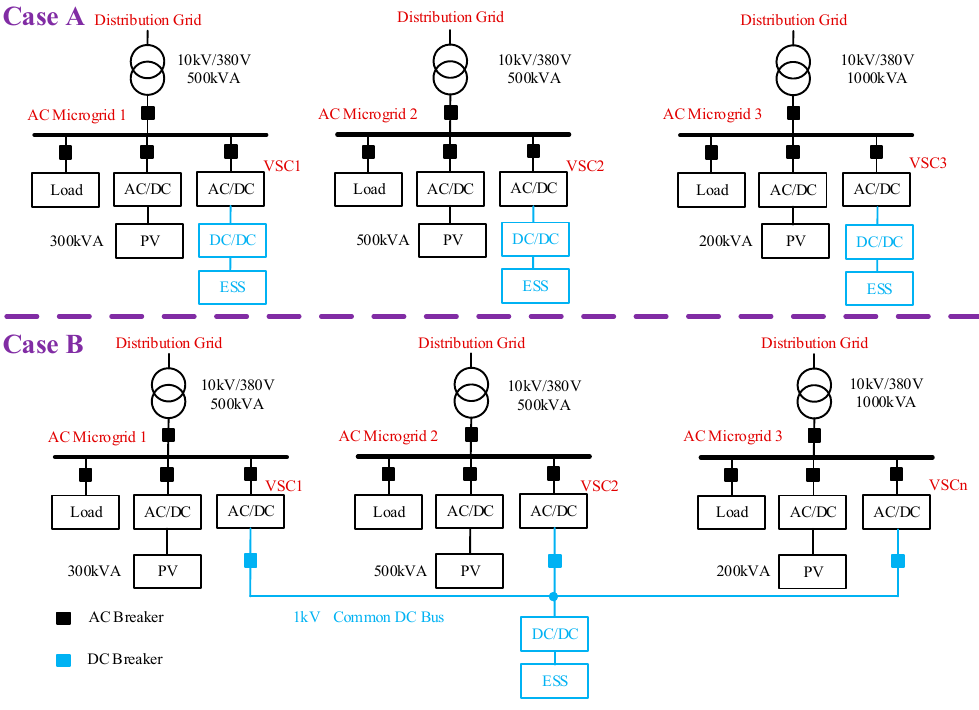
Figure 7. Microgrid configurations for the case study.